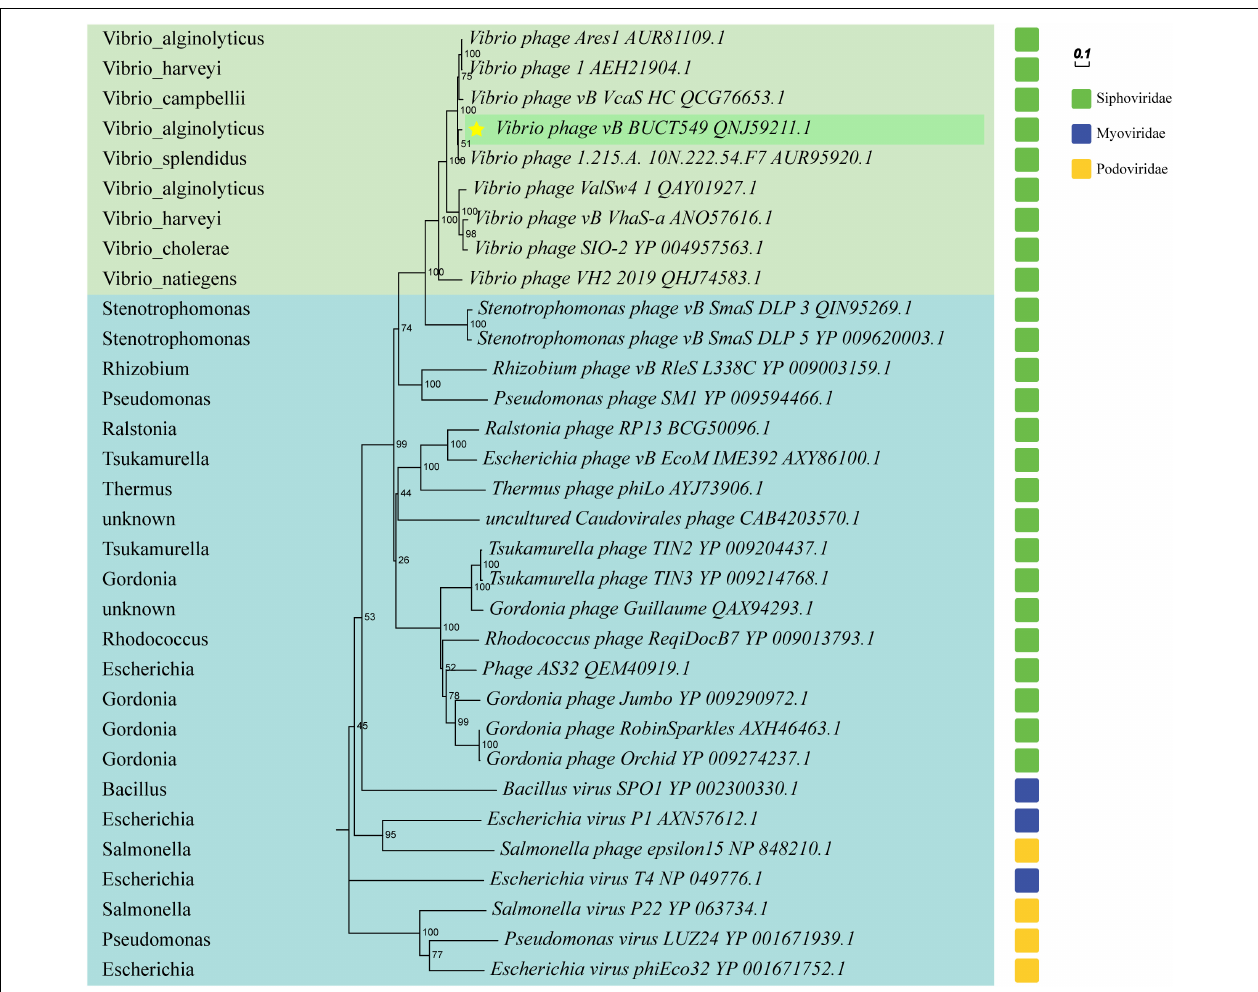
FIGURE 7 | Phylogenetic trees based on terminase large subunit, and partial phages of the Myoviridae and Podoviridae are selected as outgroups. Vibrio phages are marked in light green, and other host phages are marked in light blue. Hosts for all phages are shown on the left of the phylogenetic trees.